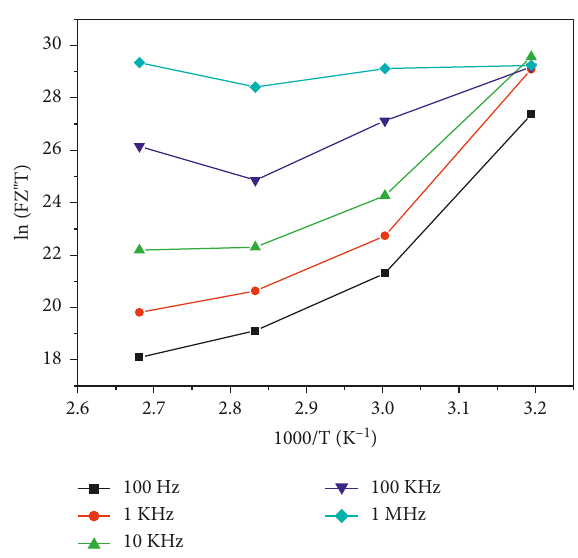
Figure 10: ln (FZ”T) vs 1000/T (K -1 ).